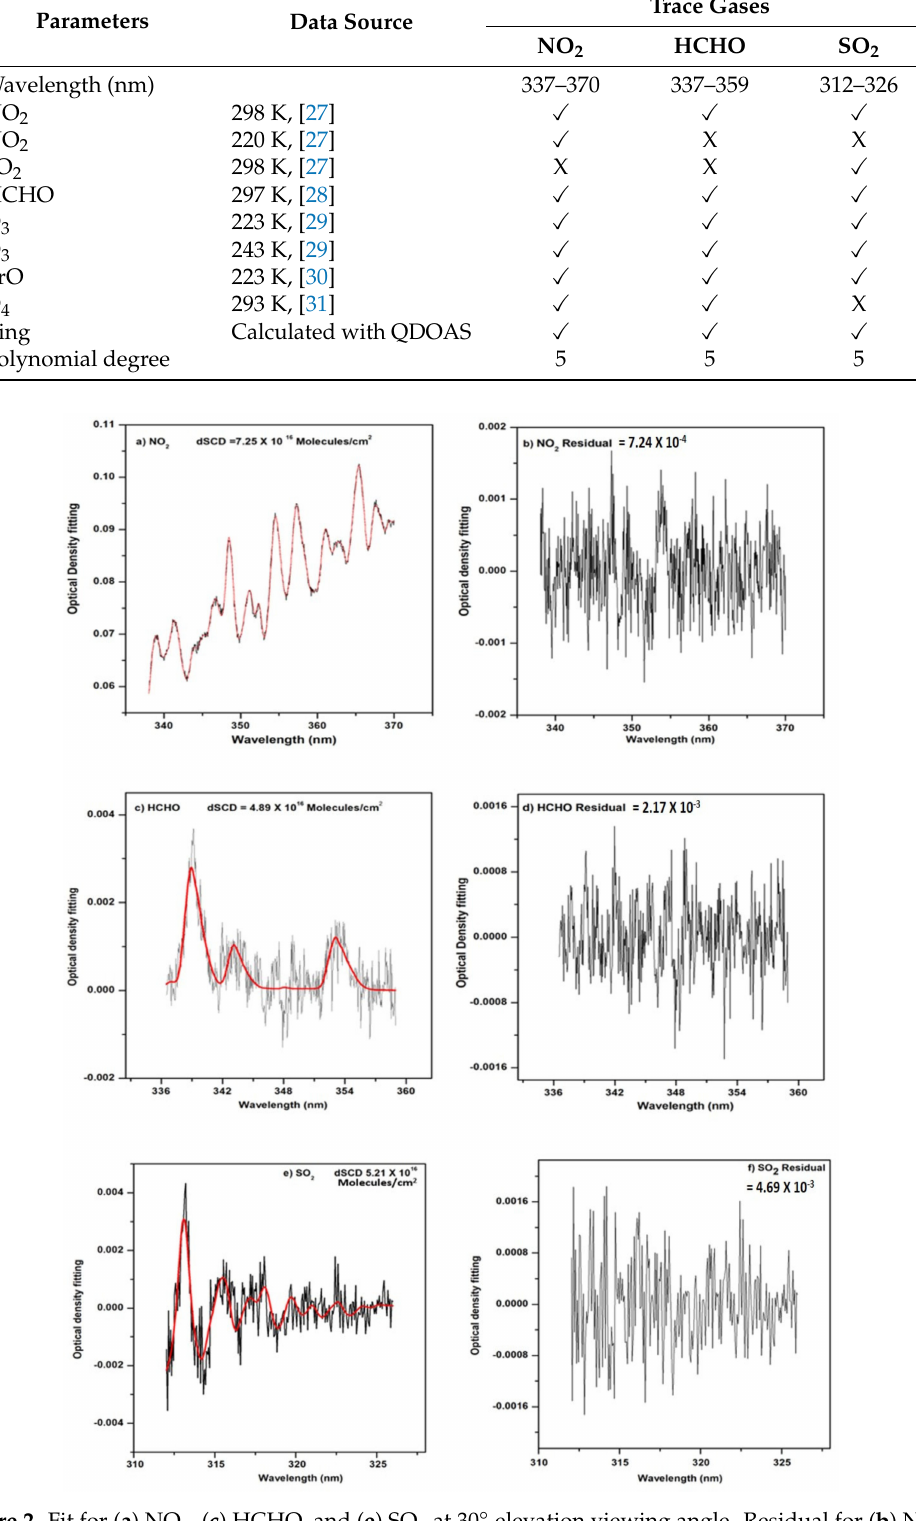
Figure 2. Fit for ( a ) NO 2 , ( c ) HCHO, and ( e ) SO 2 at 30 ◦ elevation viewing angle. Residual for ( b ) NO 2, ( d ) HCHO, and ( f ) SO 2 at 30 ◦ elevation viewing angle. Fitted optical densities are represented by a red line while measured densities are denoted by the black line. The spectra were obtained on 5 January 2020, at Nanjing